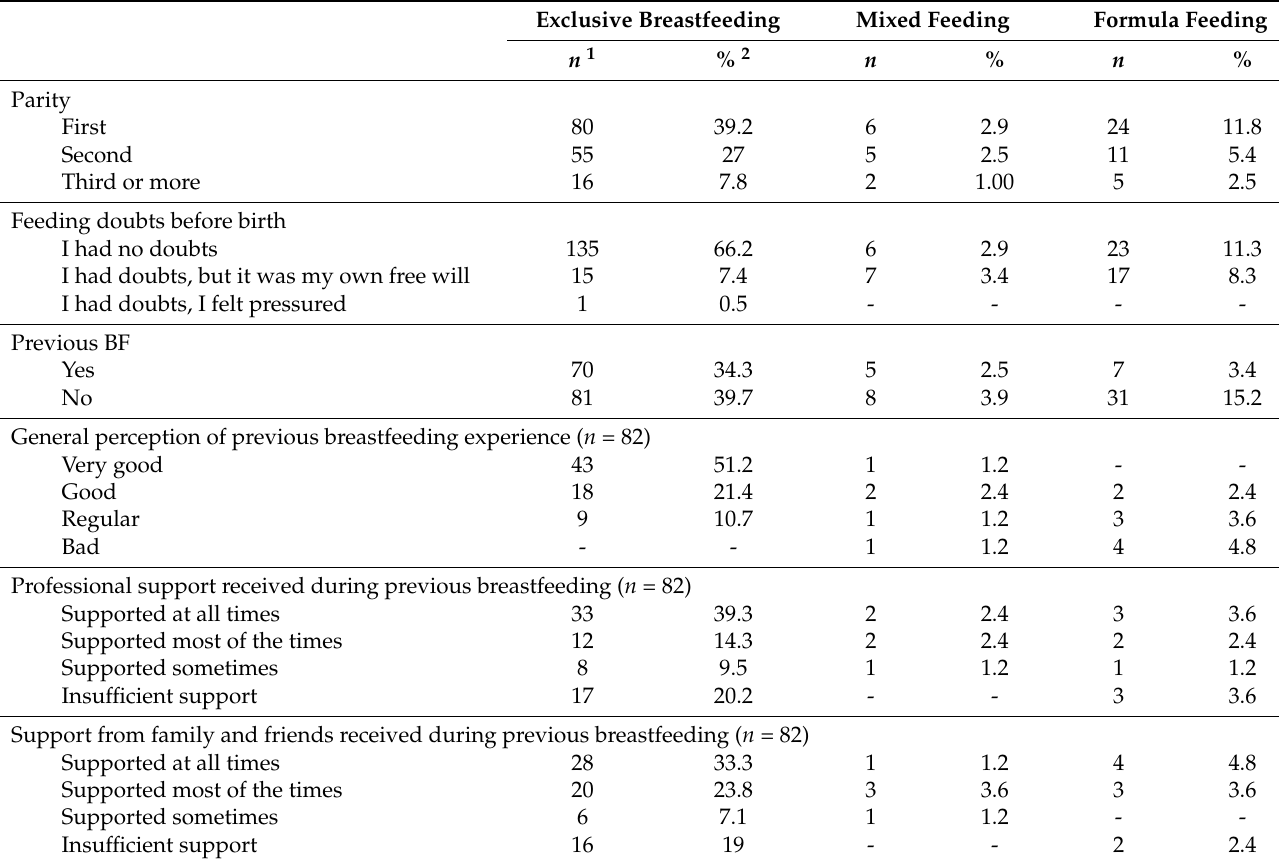
Table 5. Descriptive analysis of obstetric and breastfeeding-related